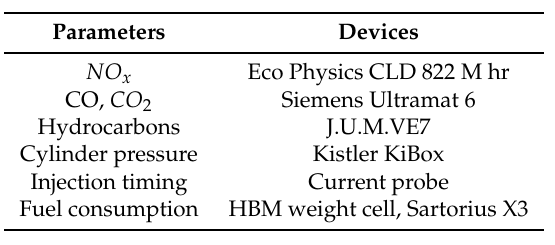
Table 3. Analytic instruments.